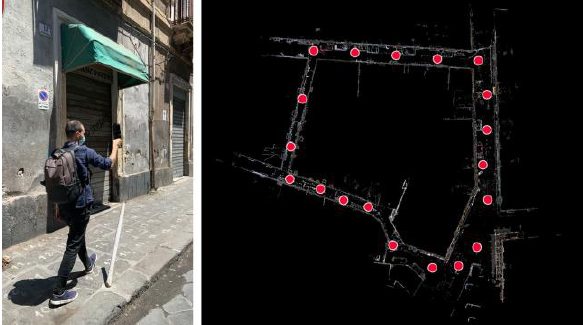
Figure 5 . On the left: BLK2GO on site during acquisition. On the right: imported point cloud in Register360.